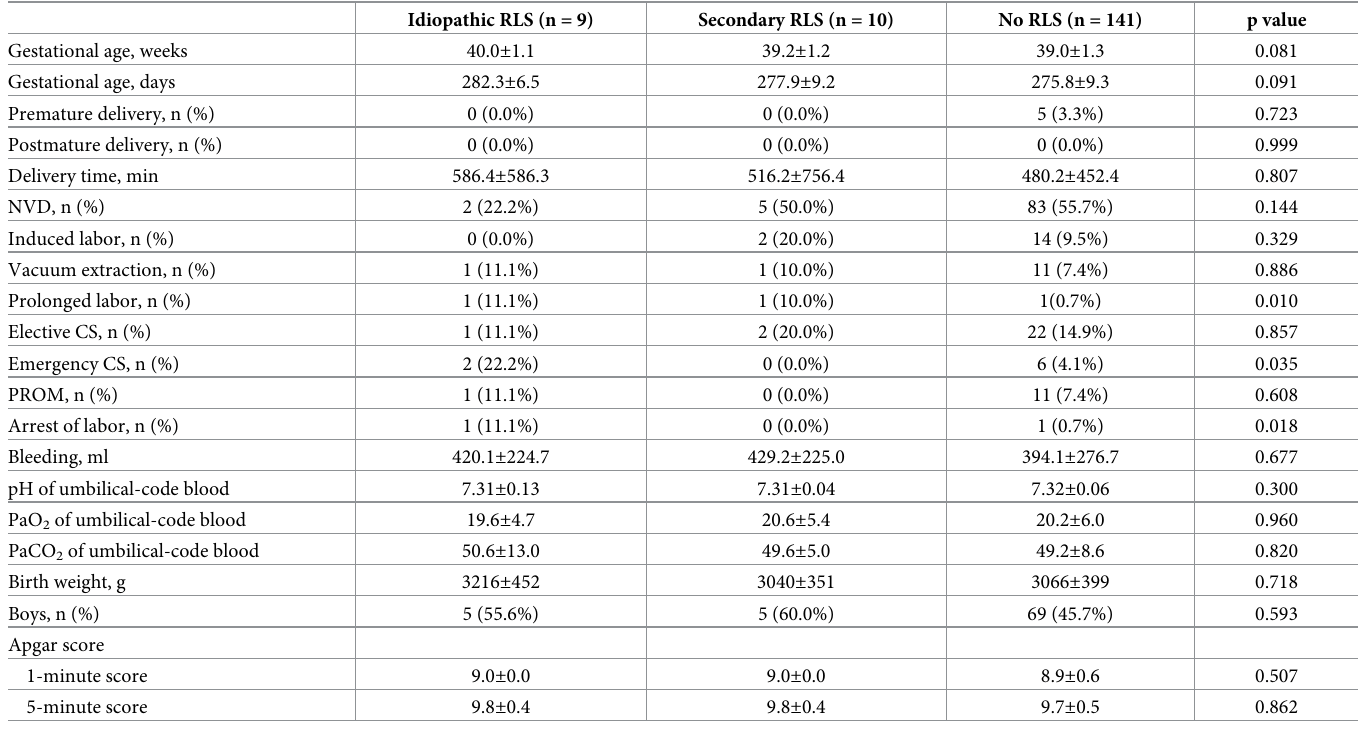
Table 4. Delivery-related data according to presence and type of restless legs